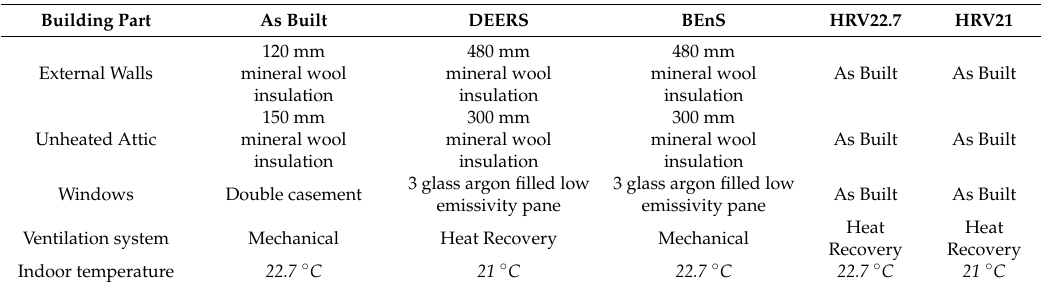
Table 1. Investigated refurbishment packages.